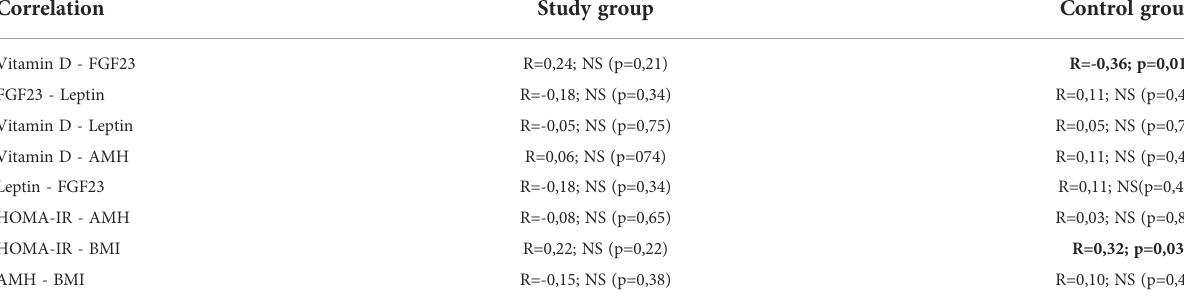
TABLE 5 Spearman ’ s correlations in the study and control